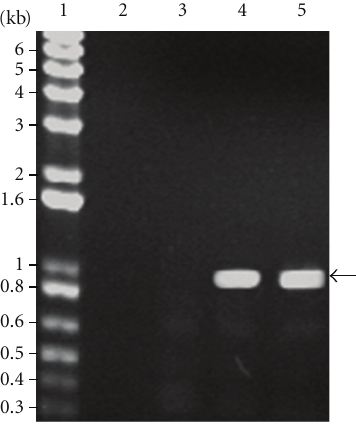
Figure 2: Amplification of zwittermycin A gene by the polymerase chain reaction. Lane 1, 1kbp plus DNA ladder (Invitrogen); lane 2, control without DNA; lane 3, B. subtilis 21; lane 4, B. thuringiensis subsp. morrisoni (LBIT 269); lane 5, B. cereus 183. Arrow indicates the position of an amplicon of ∼ 0 . 9Kb corresponding to the zwittermycin A